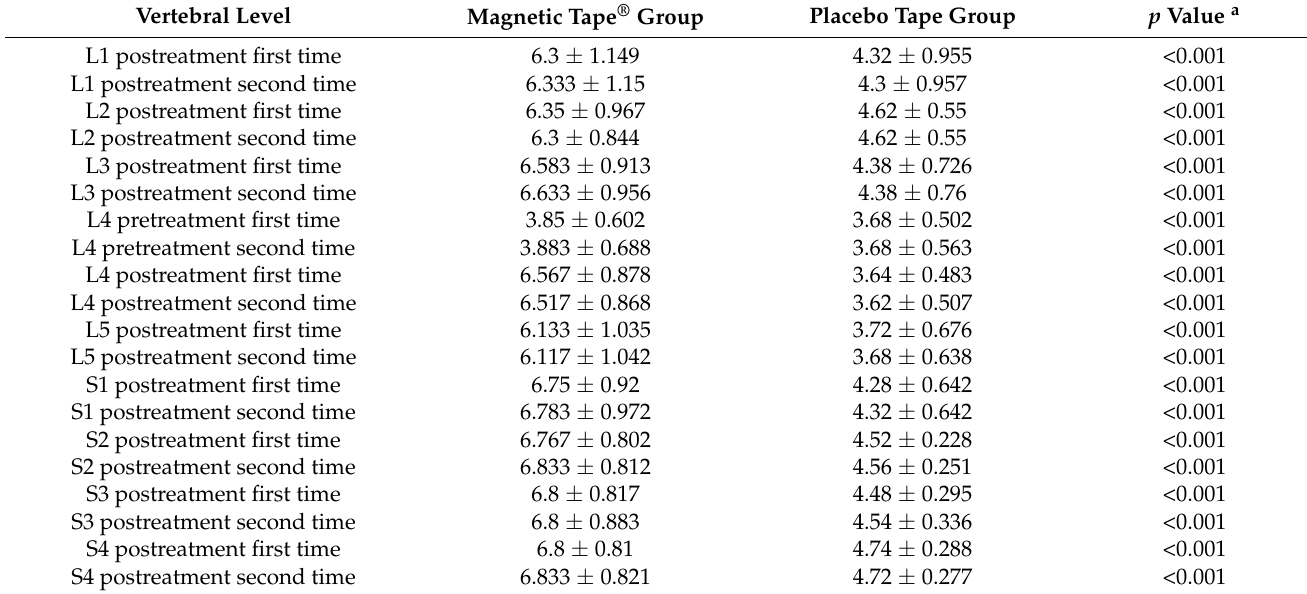
Table 9. Exact permutation test: pressure pain